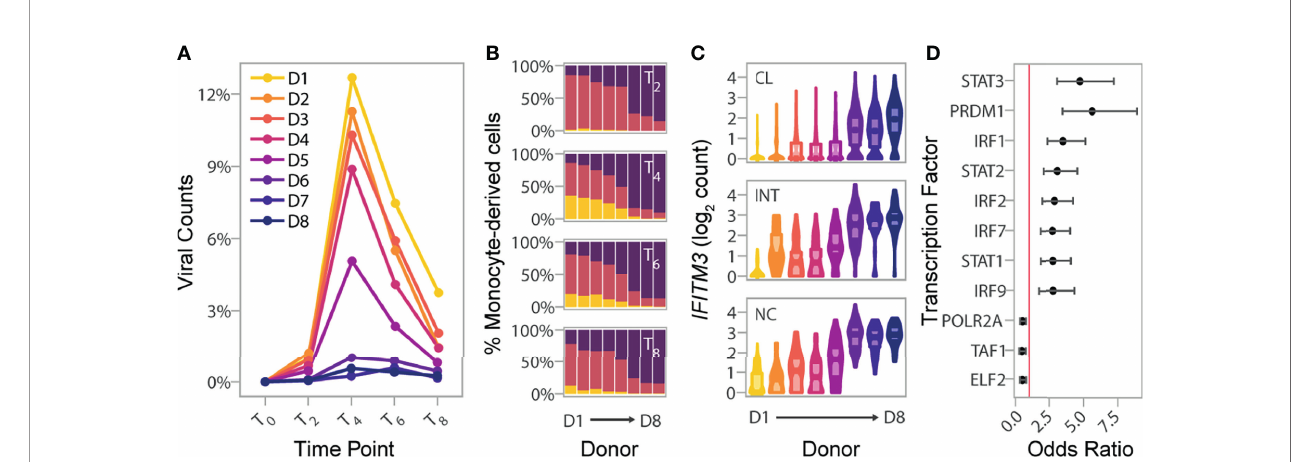
FIGURE 4 | Basal IRF/STAT-induced transcriptional network underlies inter-individual differences in monocyte susceptibility and IAV levels. (A) Pseudo-bulk estimates of the percentage of counts of viral origin in IAV-challenged condition (T 2 -T 8 ). Donors are colored based on the rank of these pseudo-bulk estimates at the peak of viral transcription, T 4 , from that with highest observed viral mRNA level (D1) to that of the lowest (D8). (B) Proportions of cell states from the IAV-challenged condition at T 2 , T 4 , T 6 , and T 8 , in the eight donors. X-axis is ordered by decreasing viral mRNA levels found at T 4 (D1-D8). (C) Log normalized expression values of IFITM3 across all cells, strati fi ed by canonical monocyte subsets, and separated by donor. Colors re fl ect the different donors depicted in (A) For each donor and monocyte subset, the violin plots show the full distribution of IFITM3 expression across individual cells and boxplots highlight the median and interquartile range. (D) Enrichment of SCENIC-predicted targets among the 118 genes whose basal expression at T 0 correlates with the percentage of infected cells at later time points (odds ratio and 95% con fi dence interval). Red line designates an odds ratio equal to 1. Only TFs signi fi cantly enriched among the 118 candidate genes are shown (FDR < 0.05). CL, classical; INT, intermediate; NC,